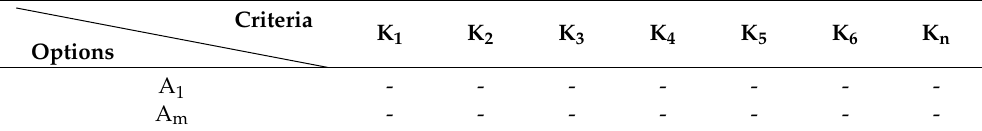
Table 14. Normalized Matrix M